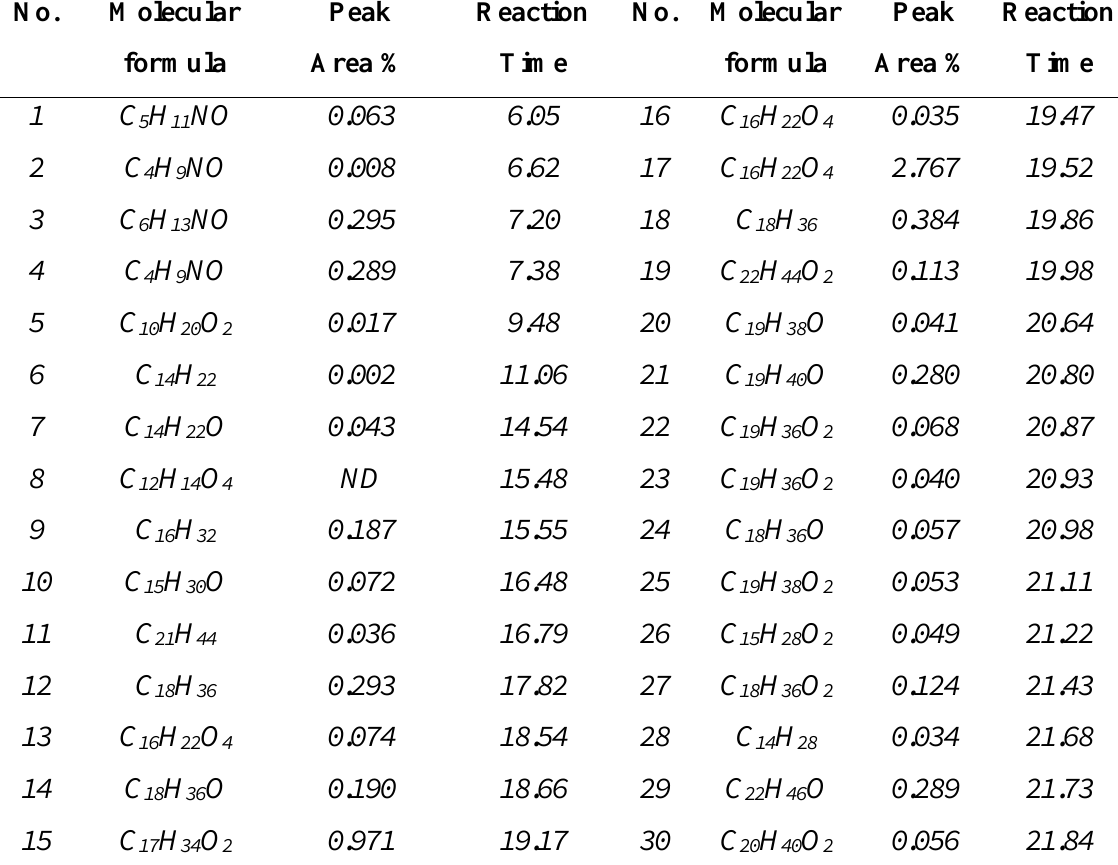
Table 3. GC–MS analysis for oil of algae C.